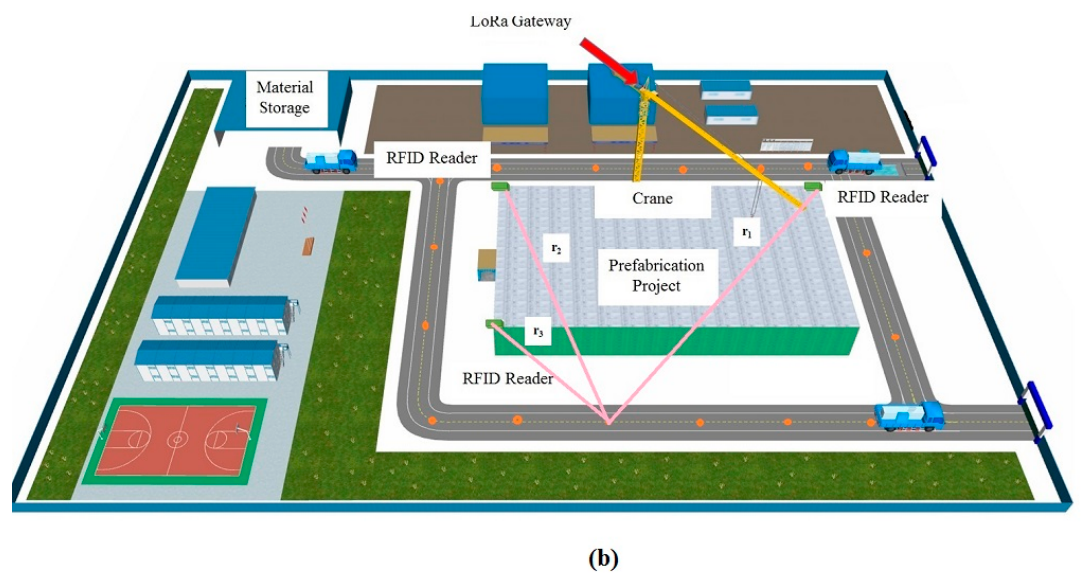
Figure 17. ( a ) The BIM model of the construction site; ( b ) the 16 pre-set locations in the BIM model. Sensors 2019 , 19 , x FOR PEER REVIEW